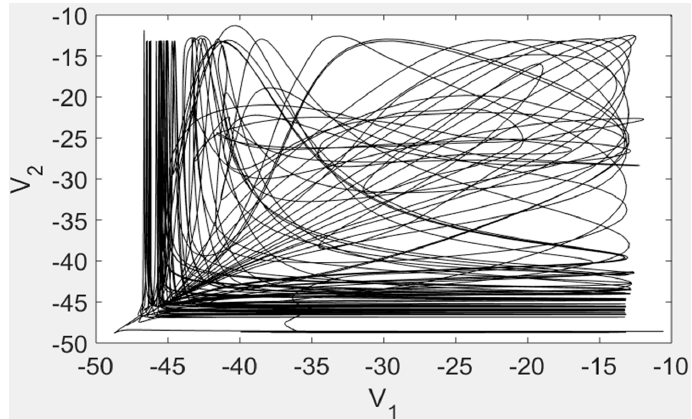
Figure 12. Locus (V 1 , V 2 ) when τ = 2.5 and H syn = 5.3.